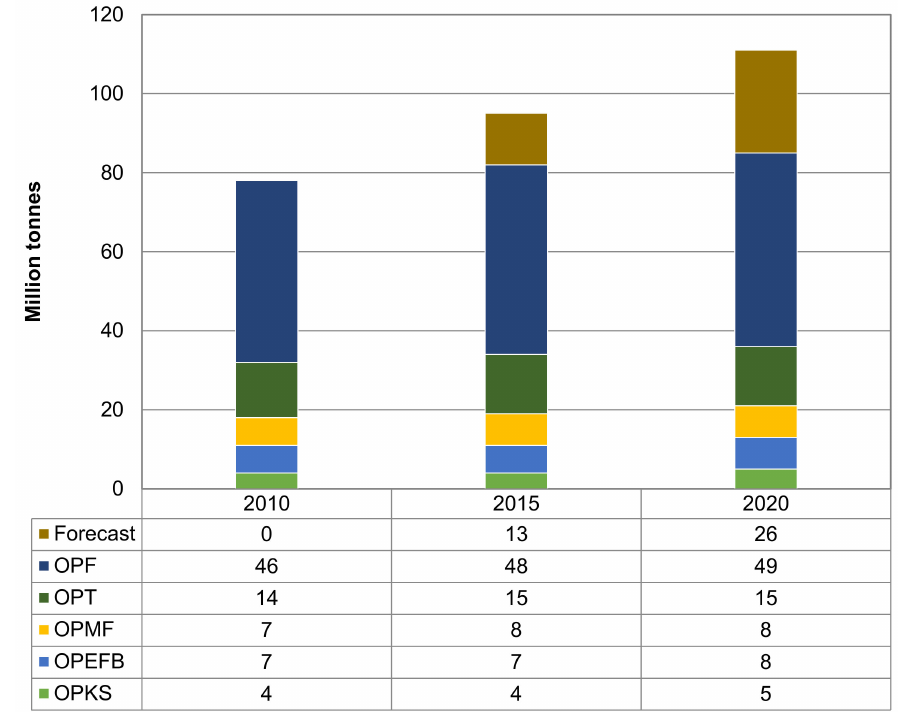
Figure 1. Production of oil palm biomass, i.e.,: oil palm frond (OPF), oil palm trunk (OPT), oil palm mesocarp fiber (OPMF), oil palm empty fruit bunch (OPEFB), and oil palm kernel shell (OPKS). Data obtained from Malaysia Innovation Agency